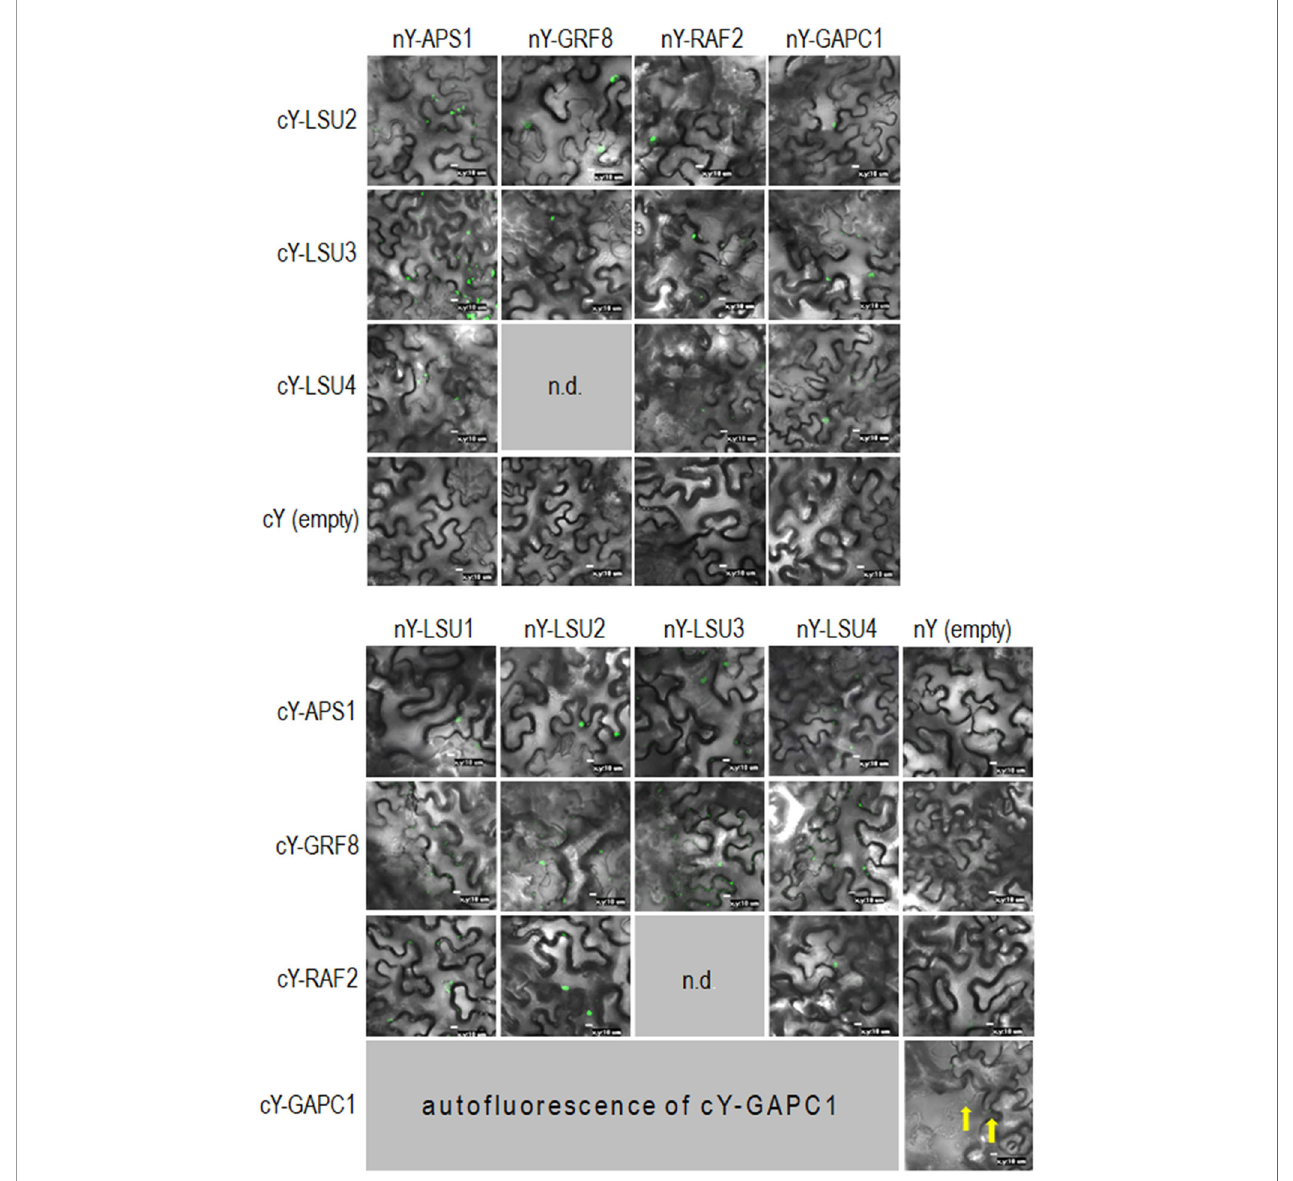
FIGURE 6 | Representative Bimolecular Fluorescence Complementation (BiFC; green spots) of LSUs with APS1, GRF8, RAF2, and GAPC1. The proteins were selected from proteins co-purifying with LSUs in TAP-MS experiments. cY and nY represent the C-terminal and N-terminal sections of YFP, respectively, fused to the indicated protein or present in empty vector. n.d, no data for this combination. The yellow arrows point to auto fl uorescence of cY-GAPC1. The enlarged versions of the images presented in Figure 6 are shown in Supplementary Figure